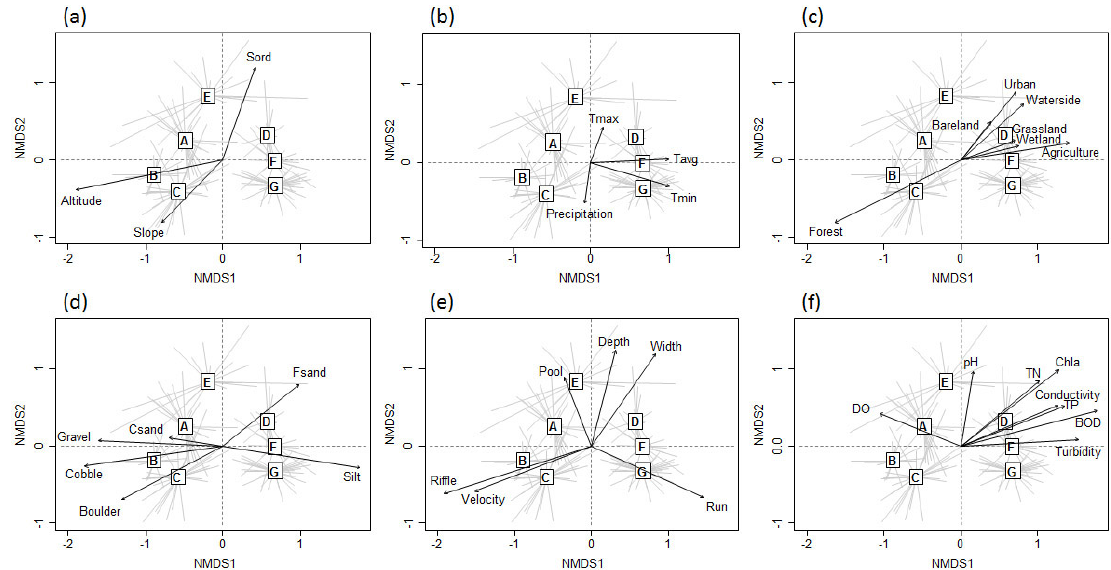
Figure 6. Biplots of environmental variables in six different categories of NMDS ordination: ( a ) Geography; ( b ) meteorology; ( c ) land use; ( d ) substrate composition; ( e ) hydrology; and ( f ) physicochemical water quality. Abbreviations for the variables are given in Table 1.